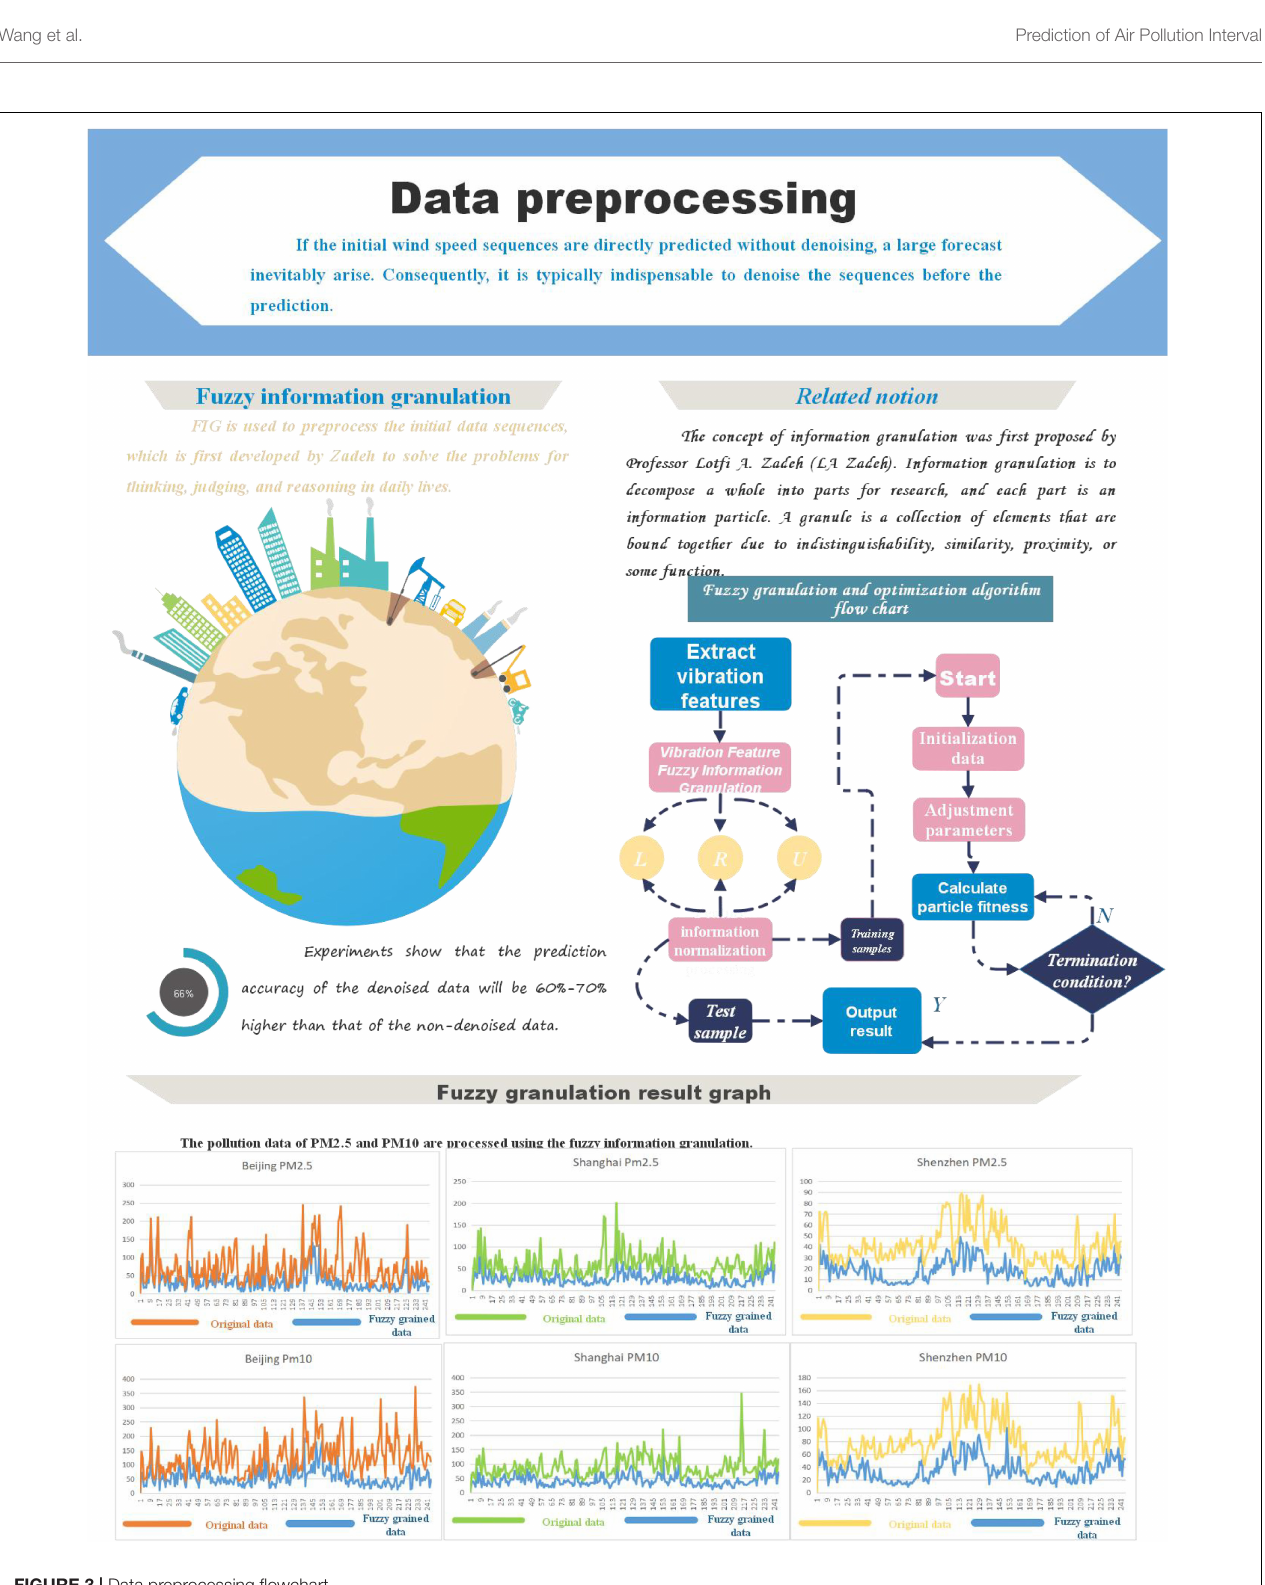
FIGURE 3 | Data preprocessing flowchart.